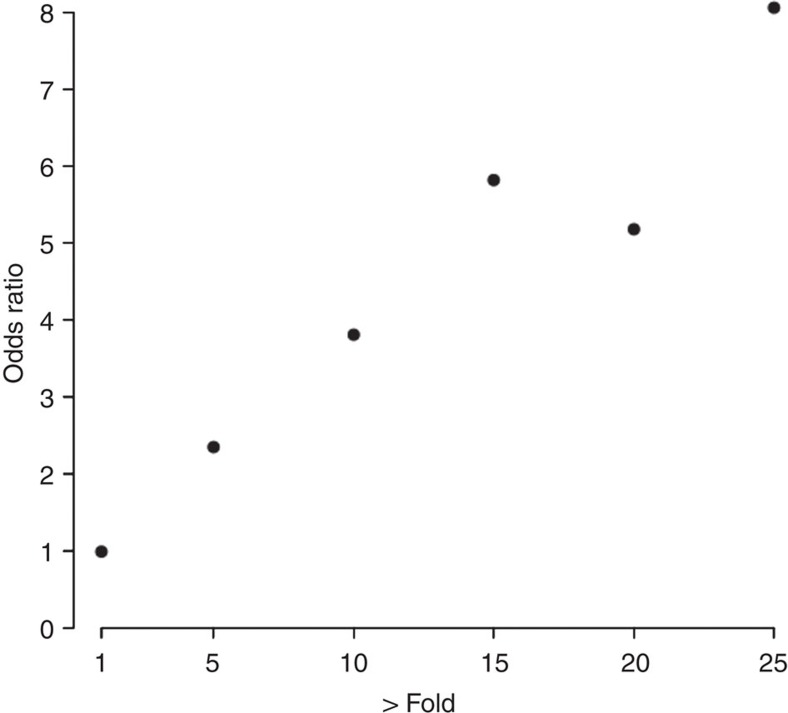
Enrichment of missense variants among those variants that have increased in frequency above incremental fold change thresholds in MANOLIS versus TEENAGE analysis.At each threshold, we computed a contingency table comparing the number of missense and other variants found at a fold change higher than the threshold. Odds ratios were used to quantify enrichment. For example, an odds ratio of 2.35 above a fold change threshold of 5 indicates that variants that have drifted in frequency by more than fivefold in the MANOLIS isolate compared with the TEENAGE general population are 2.35 times more likely to be missense than variants below this threshold.